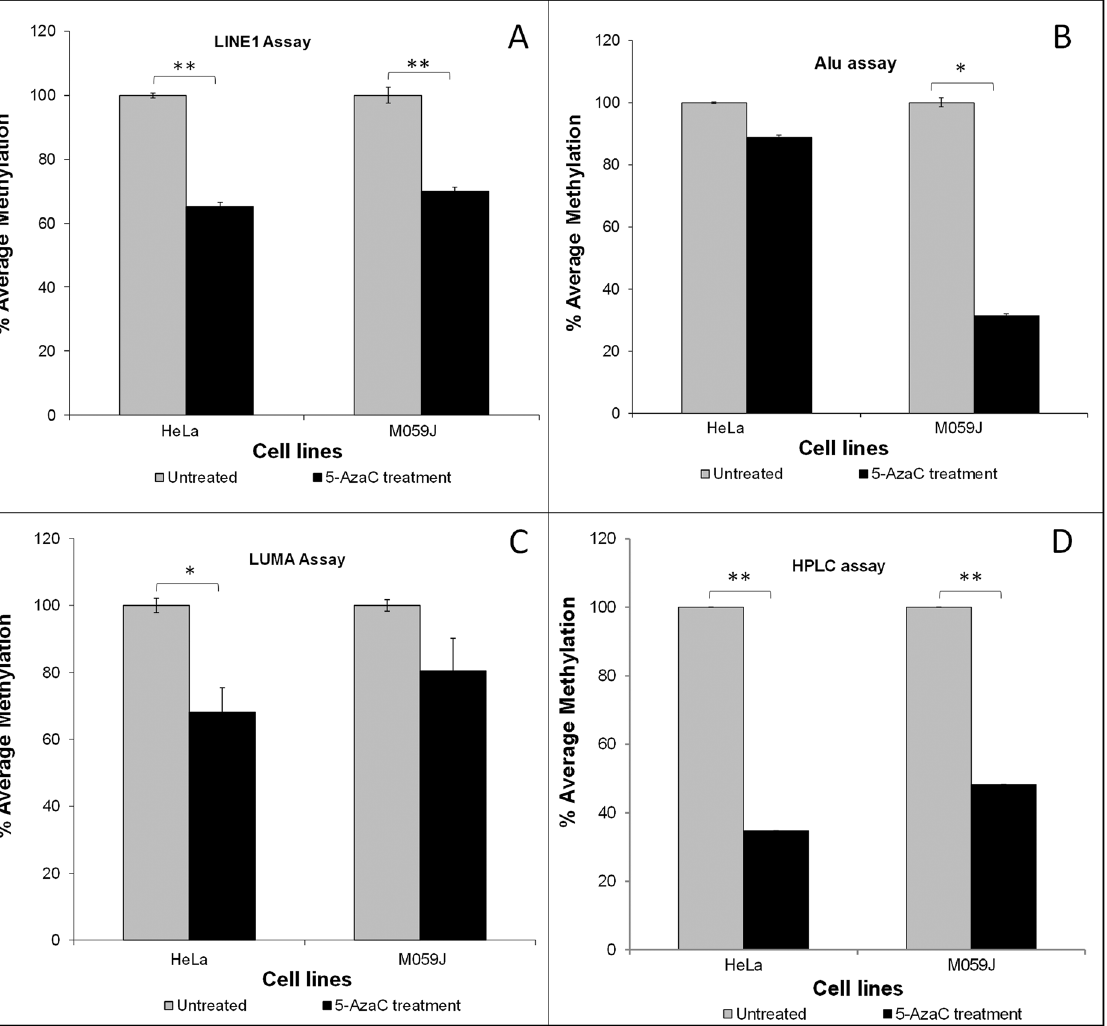
Figure 1. Methylation levels cell lines before and after treatment with the demethylating agent 5-AzaC. As assessed by: A) the LINE1 assay (** P # 0.001), B) the Alu assay (* P =0.009), C) the LUMA assay (* P =0.019), and D) the HPLC method (** P # 0.001). Data are presented as the mean % of methylation (n=3) relative to the control (i.e. untreated cells). Error bars represent standard deviations.